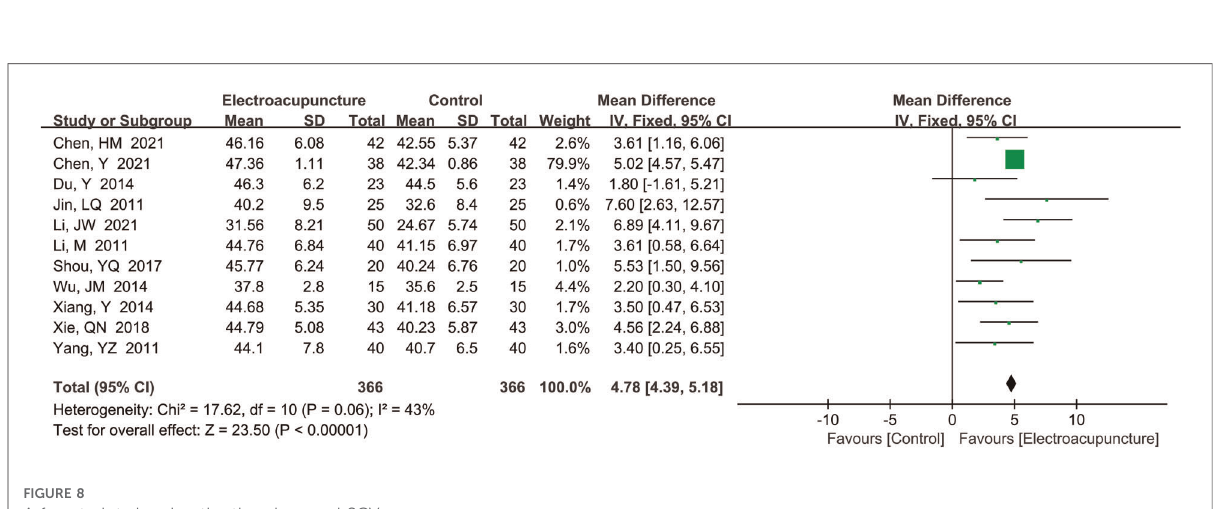
FIGURE 8 A forest plot showing the thumb-carpal